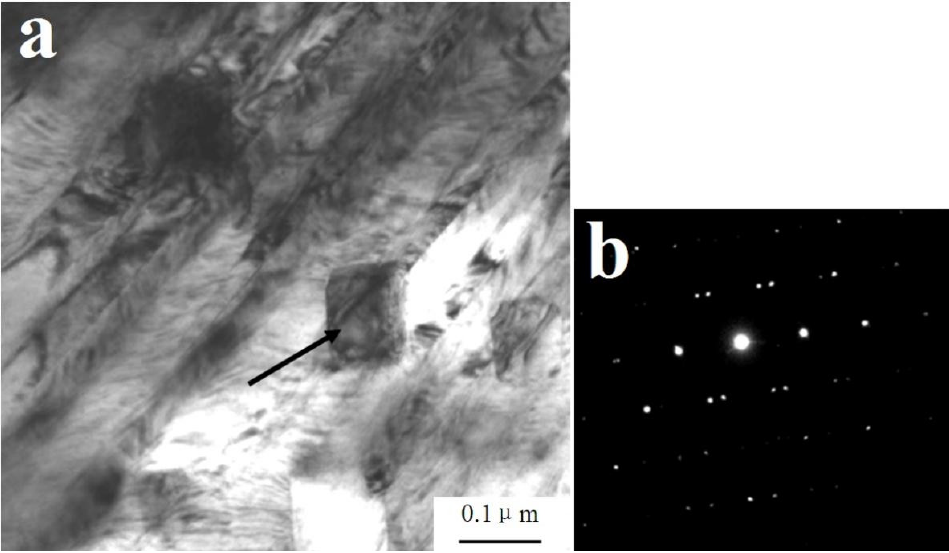
Figure 5. Twins in the matrix of W f /Cu82Al 10 Fe 4 Ni 4 composites after dynamic compression at 400 °C with the strain rate of 1600 s −1 : ( a ) twins and ( b ) SADP of twins. As indicated by arrows in Figure 6a,b, after dynamic compression at 600 ◦ C, it could also be observed that there were annealing twin structures existing inside and around the grains. The annealing twins appeared and developed together with the recrystallized grains and were mainly inside and around the recrystallized